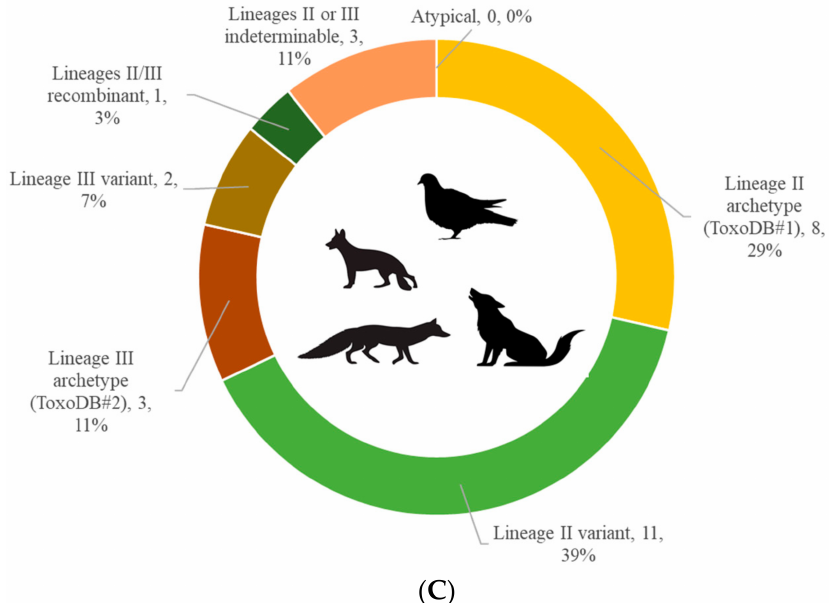
Figure 1. ( A ) Total population structure of T. gondii in intermediate hosts. The structure was inferred from 67 strains of human origin ( n = 24), domestic animals ( n = 15), and wildlife ( n = 28), representing nine species of intermediate hosts; ( B ) Population structure of T. gondii in the domestic environment. The structure was inferred from 39 strains of human origin ( n = 24) and domestic animals ( n = 15), representing four species of intermediate hosts. The majority of strains detected in domestic pigs ( Sus scrofa domesticus ) originated from confined animals, while the strains isolated and detected in horses ( Equus caballus ), chicken ( Gallus gallus domesticus ), and sheep ( Ovis aries ) originated from free-range animals; ( C ) Population structure of T. gondii in the sylvatic environment. The structure was inferred from 28 strains from four species of wildlife—feral pigeons ( C. livia , n = 3), golden jackals ( C. aureus , n = 13), red foxes ( V. vulpes , n = 10), and grey wolves ( C. lupus , n = 2). Aside from the pigeons, who originated from areas in and around Belgrade, individual animals of the Canidae family originated from suburban, rural, and remote forested areas of Serbia. In ( A – C ), each genotype category is followed by the number of strains and percentage of the total